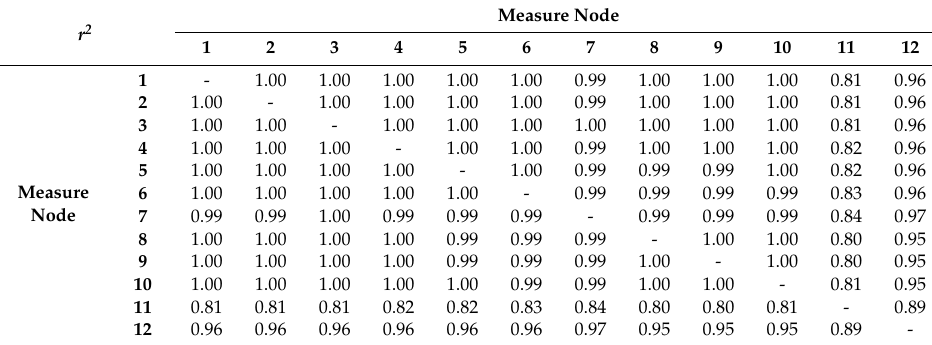
Table 2. r 2 of cases 6–7 in an SVR model.